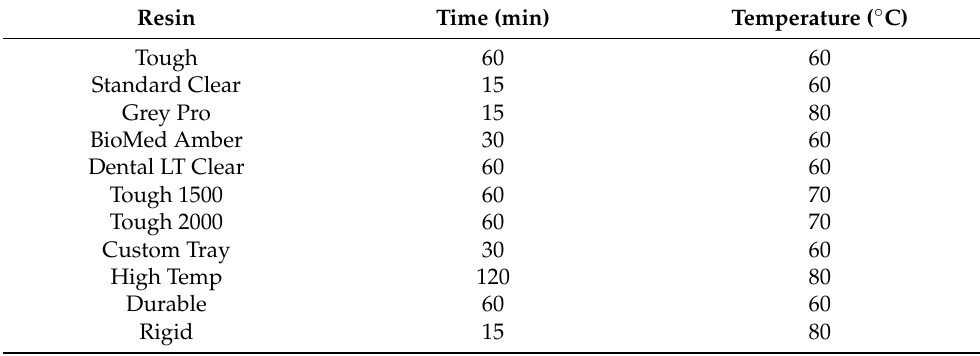
Table 1. FormCure settings [4].